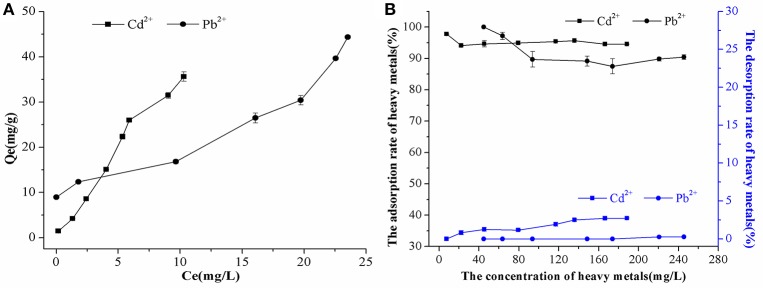
The adsorption and desorption characteristics of Cd2+ and Pb2+ by biogenic CaCO3. (A) The adsorption isotherm curves. (B) The adsorption and desorption rates. The black line represents the adsorption rate data, and the blue line represents the desorption rate data. Data represent the mean ± standard deviation (SD) of three independent experiments.